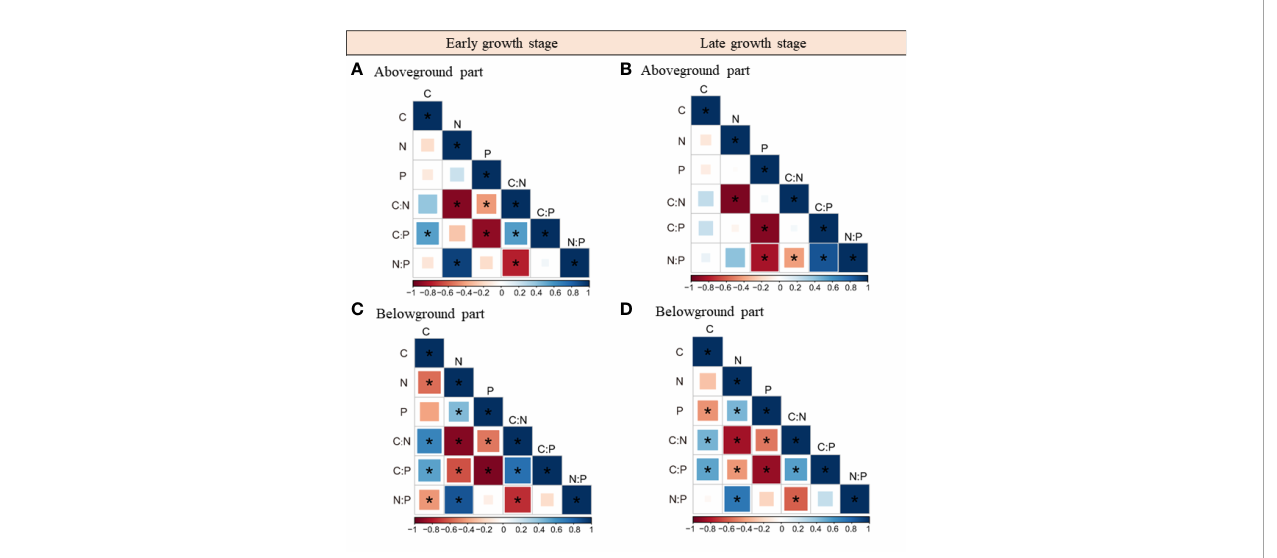
FIGURE 3 Relationships within the above- and belowground parts C, N, P stoichiometries in the early (A, B) and late growth stages (C, D) . *, represents signi fi cant correlations at the 0.05